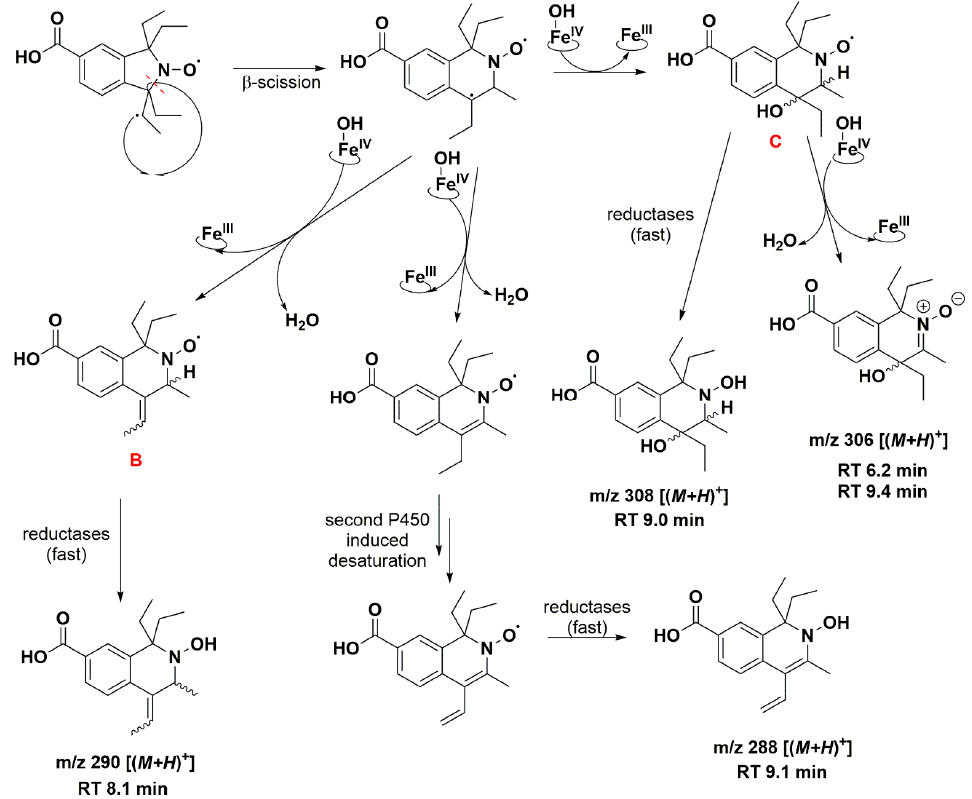
Figure 9. Proposed reaction pathway in the aerobic transformation of nitroxide 5 by RLM and NADPH, part II. Explicit hydrogens attached to carbon atoms in structures B and C correspond to potential origin of the coupling seen in the EPR spectra. Only one possible isomer is presented at each stage for the sake of clarity. The given RT values correspond to the reconstructed chromatograms of the principal ions obtained in HRMS study and were characterized by a delay of 0.2 min compared to the UV-Vis detection (see Figure 7).